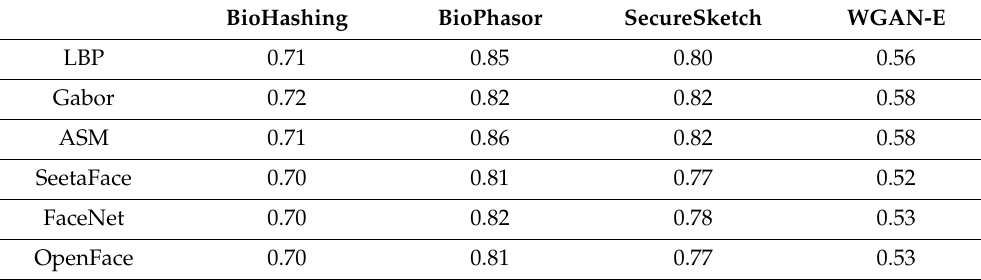
Table 7. When the key has been hacked by the impostor, equal error rate.